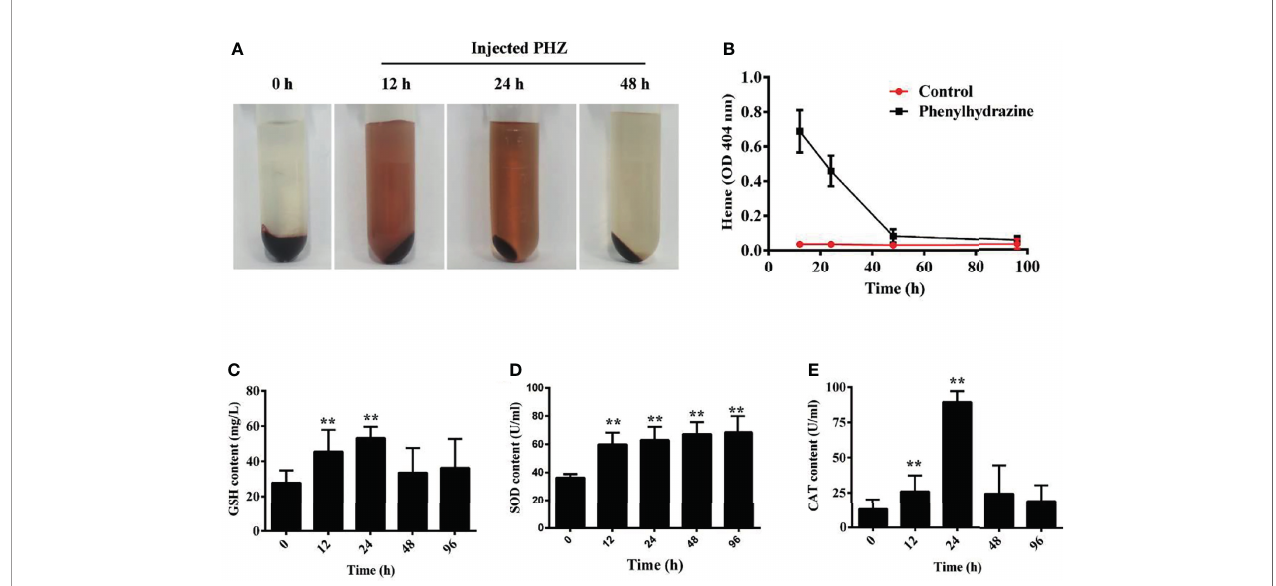
FIGURE 1 | Hemolysis caused hemoglobin (Hb) accumulation in plasma and activated the antioxidant system. (A) Plasma was obtained after phenylhydrazine (PHZ) injection for 12, 24, and 48 h (B) Hemolysis detection of plasma after injection of PHZ at different time points. (C – E) PHZ-induced hemolysis activated three kinds of antioxidases, namely, glutathione peroxidase (GSH) (C) , superoxide dismutase (SOD) (D) , and catalase (CAT) (E) . ** p < 0.01 (Student ’ s t -test). Data represent the mean ± SD of three independent